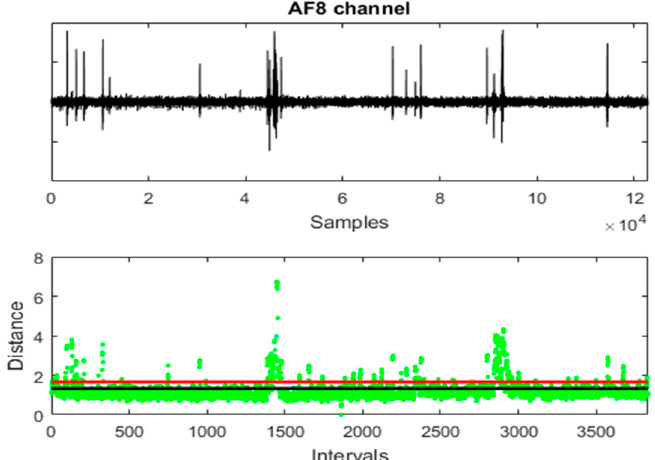
Figure 3. Histogram of interval distances and its generalized extreme value distribution.